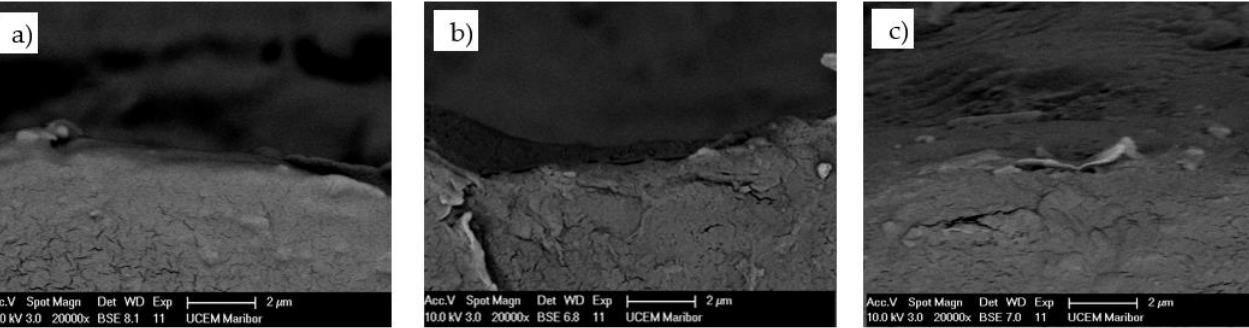
Figure 6. SEM micrograph of the coated cross section of POM-gear: ( a ) Al-coating, ( b ) Cr-coating, ( c ) CrN coating.